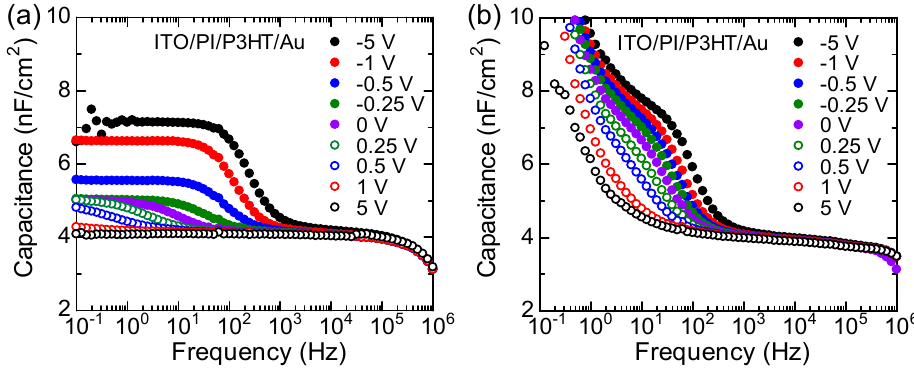
Figure 2. Frequency dependences of the capacitance of the ITO/PI/P3HT/Au MIS capacitors with ( a ) patterned and ( b ) unpatterned P3HT films measured at various gate voltages.